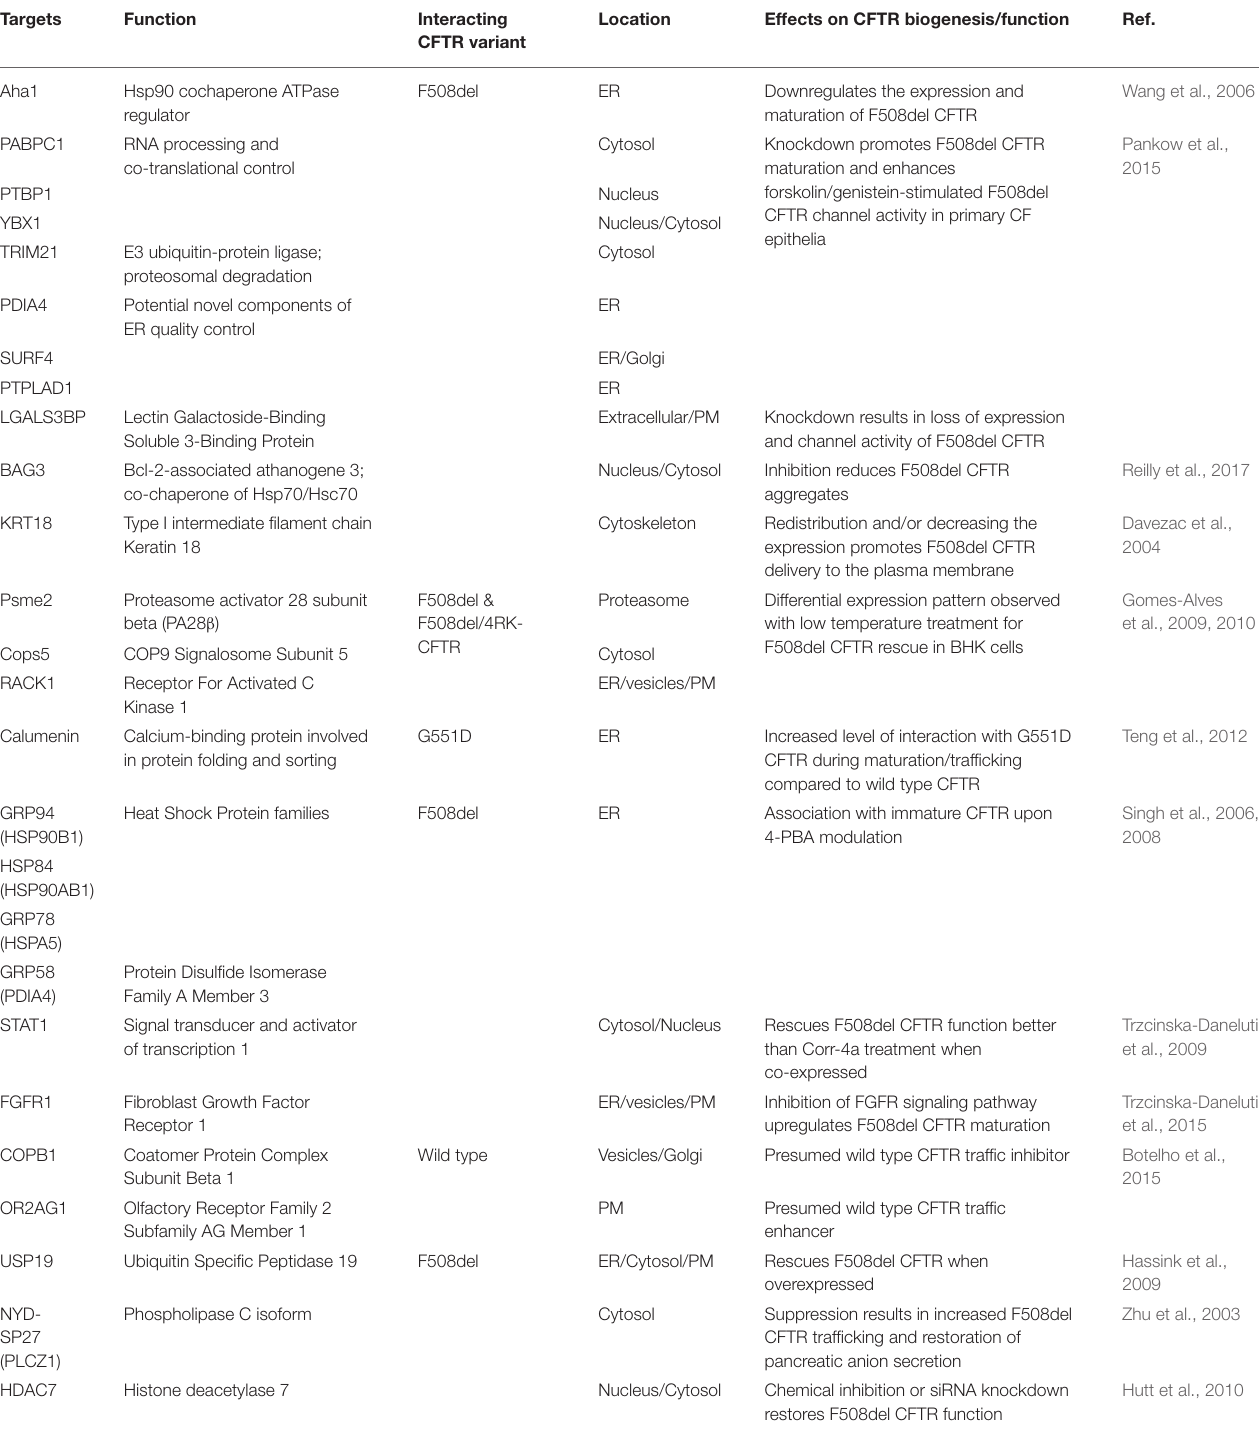
TABLE 1 | Putative CFTR-interacting targets for restoring CFTR biogenesis and function in CF identified through proteomic approaches.